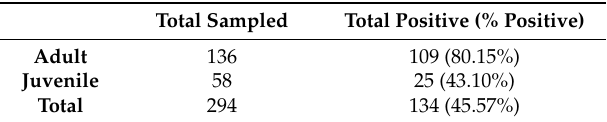
Table 2. Seroprevalence in wild-caught bats by